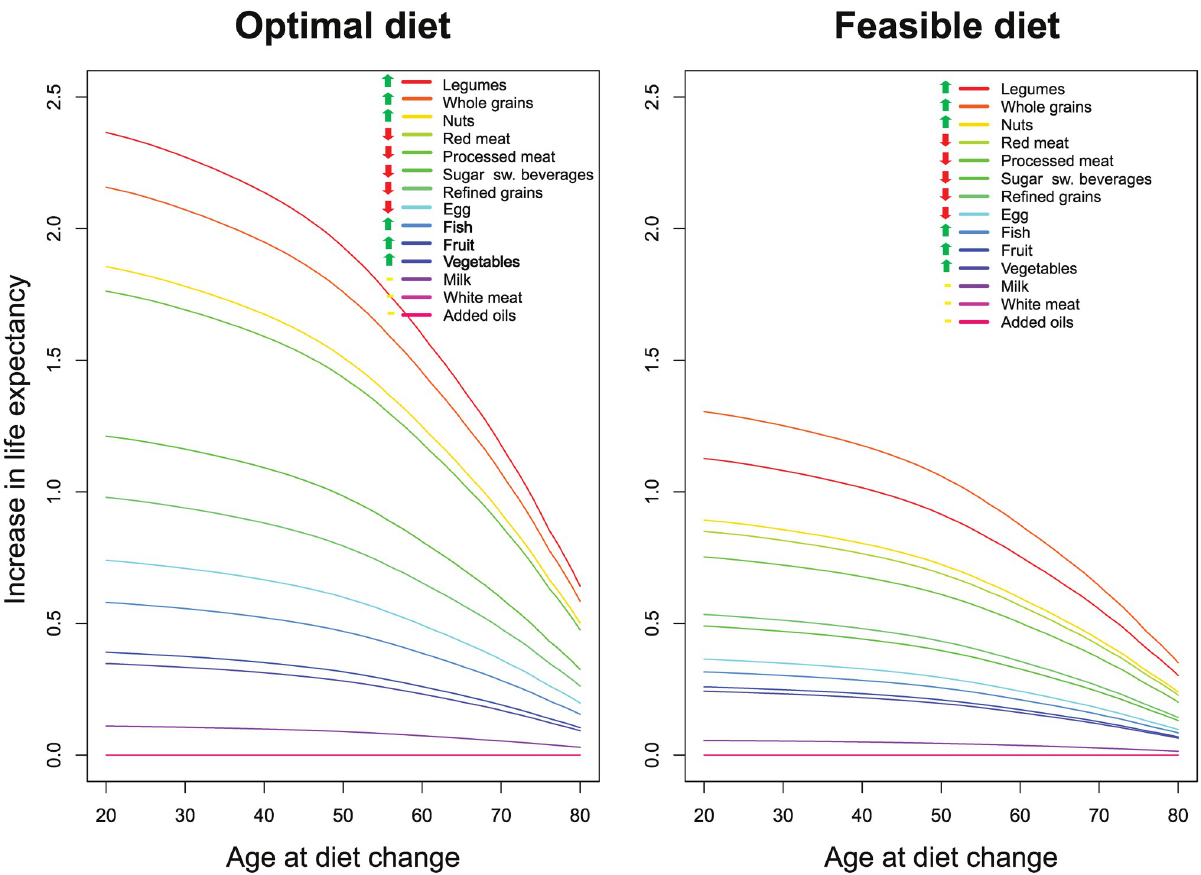
Fig 3. Expected increase in LE for optimizing different food groups with diet changes initiating from various ages between 20 and 80 years of age (left plot). Right plot presents similar estimates with a feasible approach � diet (time to full effect: 10 years). � For the optimal diet and feasibility approach diet, the following intakes were used: 225 g and 137.5 g whole grains (fresh weight), 400 g and 325 g vegetables, 400 g and/ 300 g fruits, 25 g and 12.5 g nuts, 200 g and/ 100 g legumes, 200 g and 100 g fish, 25 g and 37.5 g eggs, 200 g and 250 g milk/dairy, 50 g and 100 g refined grains, 0 g and 50 g red meat, 0 g and 25 g processed meat, 50 g and 62.5 g white meat, 0 g and 250 g sugar-sweetened beverages, and 25 g and 25 g added plant oils. Note that lines for LE for red and processed meat changes are overlapping and similarly also for white meat and added oils. LE, life expectancy.